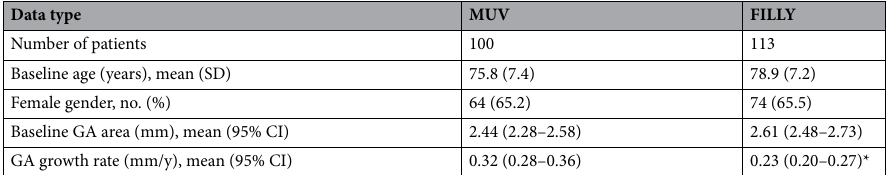
Table 1. Baseline characteristics of the study population for internal (MUV) and external (FILLY) test set. Baseline GA area and GA growth rate are presented as square root transformed values. *Calculated as the mean of all treatment groups.